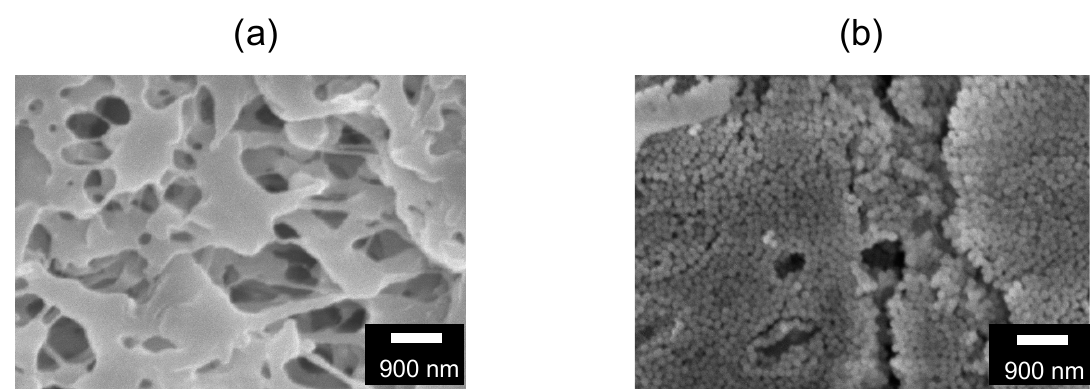
Figure 2. Scanning electron microscopy images of pore surfaces of the ( a ) PE membrane and the ( b ) silica-deposited membrane. Table 1. Properties of silica-deposited layer.